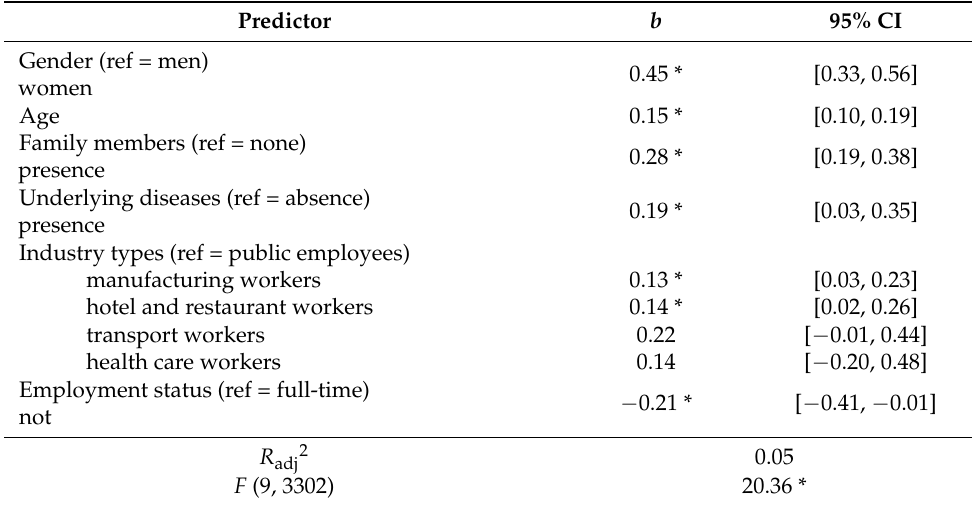
Table 5. Stepwise multiple regression analysis for CORDI